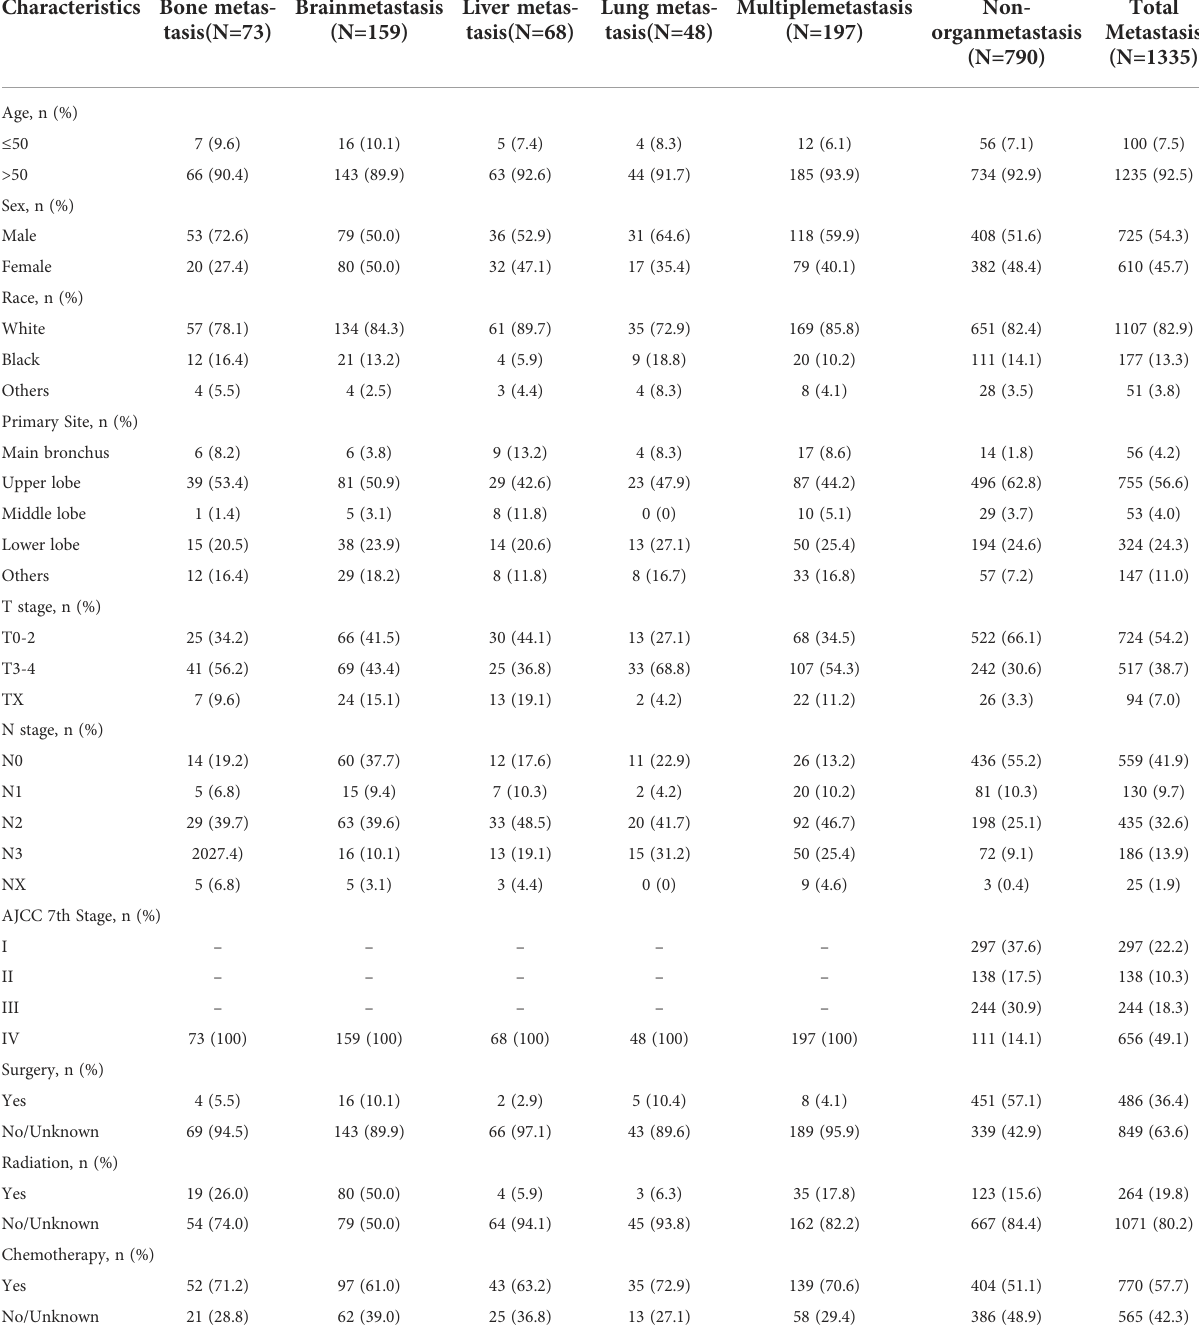
TABLE 1 Clinicopathological characteristics of patients with metastatic